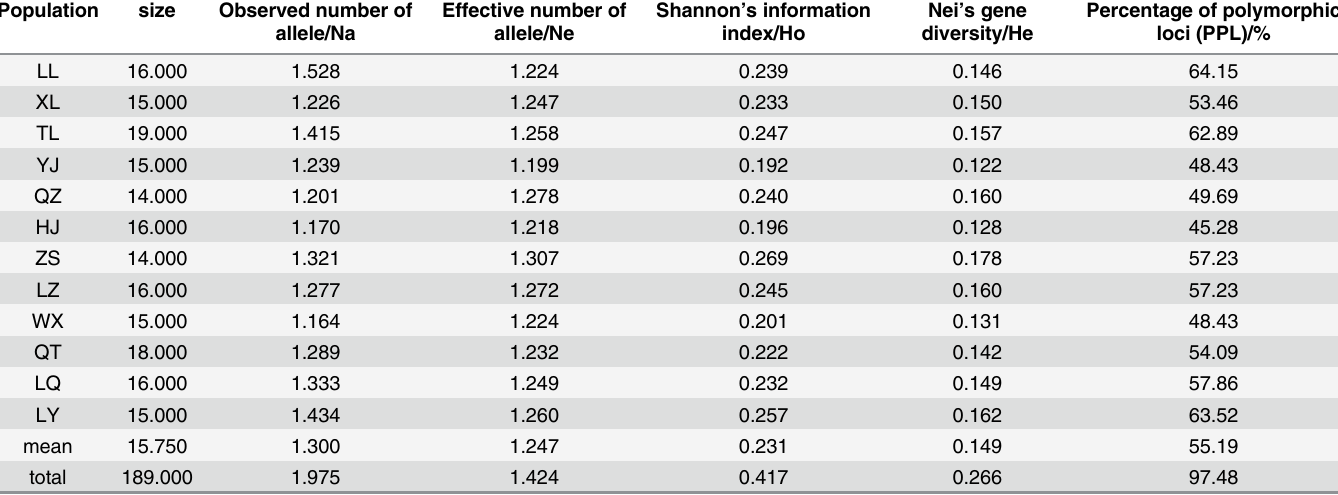
Table 2. Results of analysis of the genetic diversity of the 12 natural D . kaki var. silverstris Mak. populations. Population size